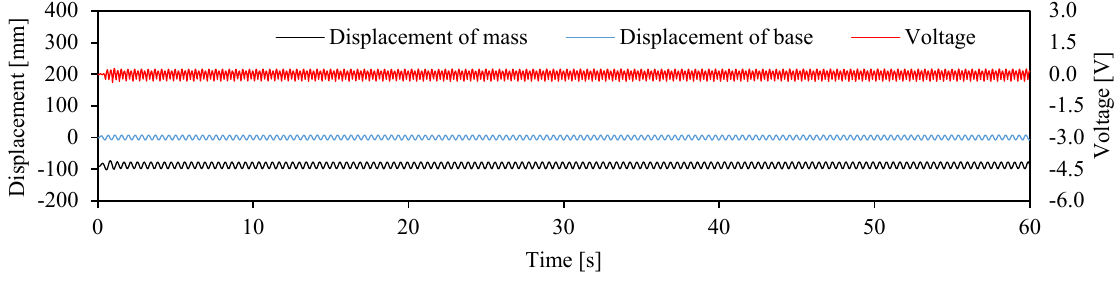
Figure 15. Measurement results for 2.2 Hz periodic signal excitation.